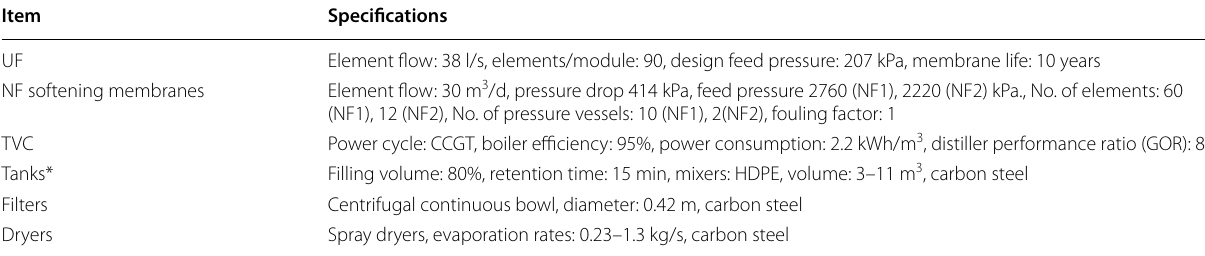
* pH adjustment and precipitation tanks